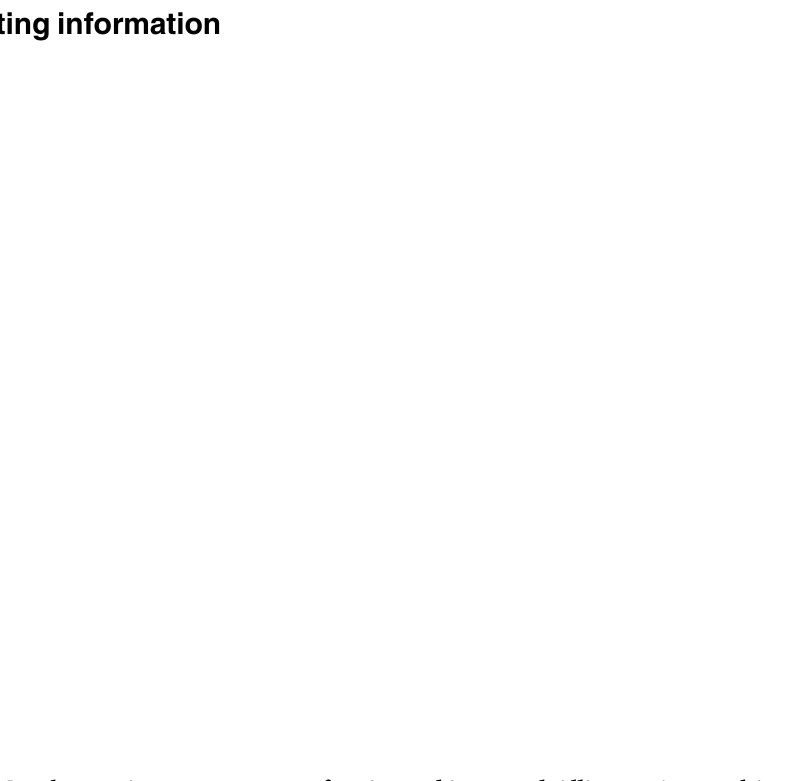
S1 Table. Morphometric measurements of native and imported Allium sativum cultivars.